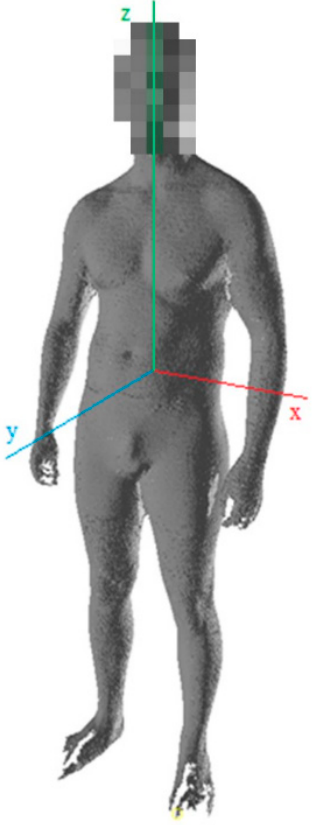
Figure 2. Sample of input with marked axis, where x—width, y—depth and z—height. Implemented neural networks were trained to detect and classify 22 standardized landmarks [29–31]. Abbreviations, names and norm references of utilized characteristic points are presented in Table 1. Table 1. List of selected standardized human body landmarks, where L—left and R—right. Abbr.